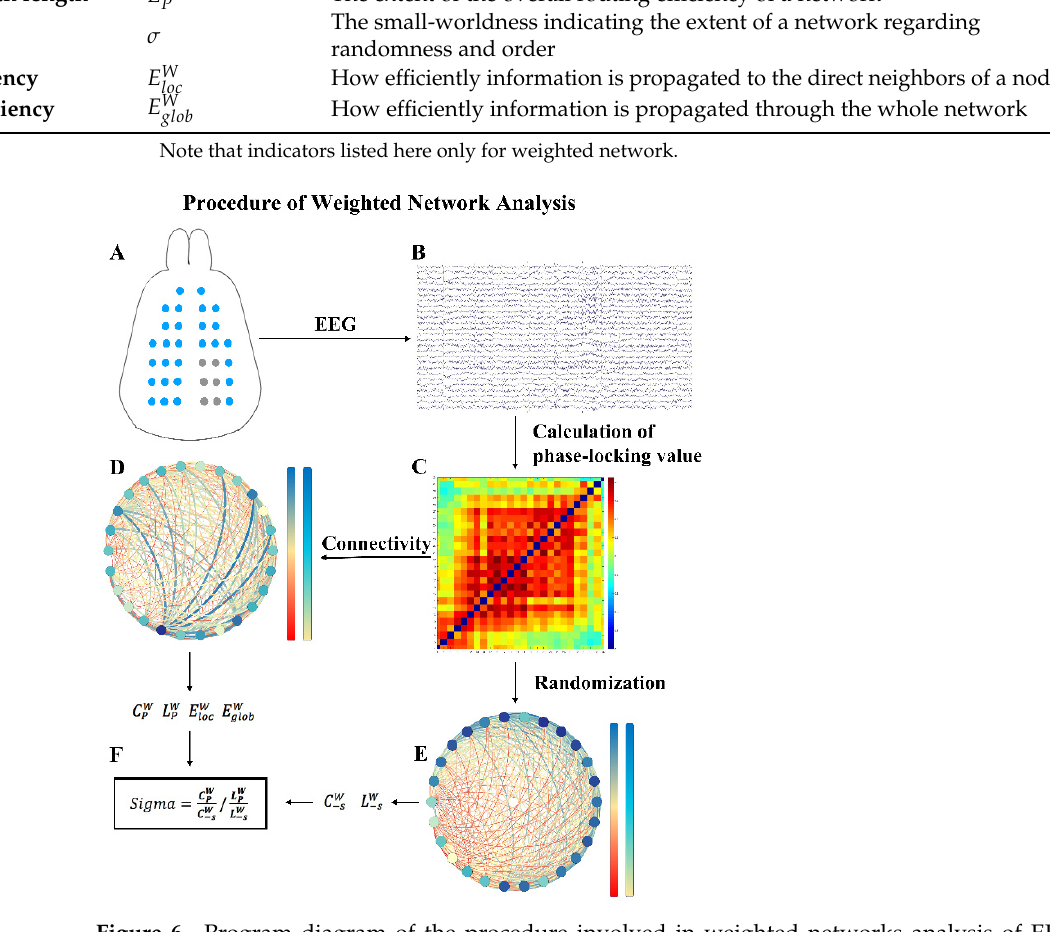
Figure 6. Program diagram of the procedure involved in weighted networks analysis of EEG recordings. ( A ) EEG signals were recorded from electrodes. ( B ) The acquired EEG signals were filtered within five frequency bands. ( C ) The PLV was estimated as a measure of correlation between all pairs of channels, resulting in correlation matrices. ( D ) Then, weighted networks were constructed based on the correlation matrices. The clustering coefficient C W , characteristic path length L W , global P P efficiency E W and local efficiency E W were calculated to characterize each graph. ( E ) In addition, glob loc surrogate graphs were derived by randomly shuffling the cells of the correlation matrices. ( F ) For each original graph, network indicators were assessed and averaged over the ensemble of